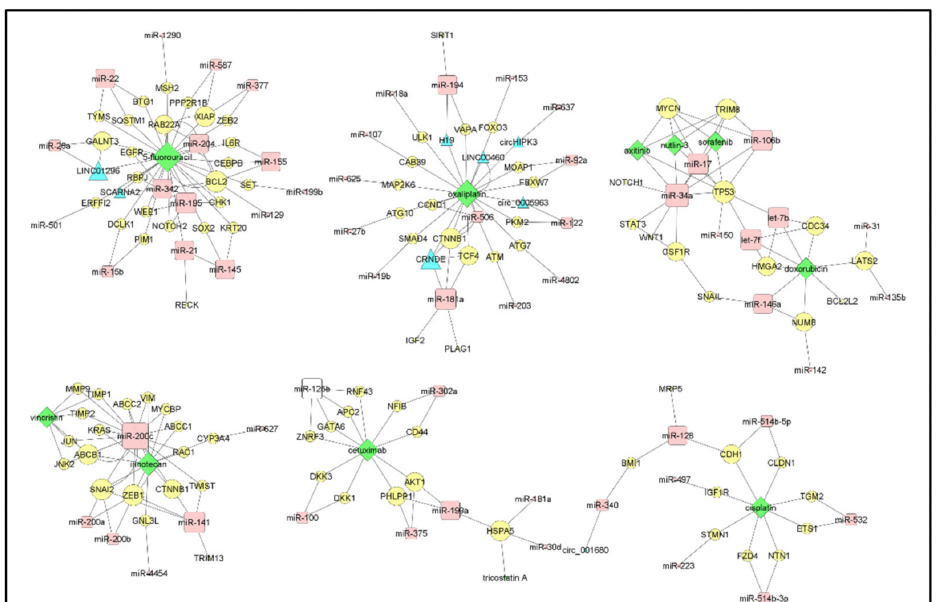
Figure 5. Clusters of miRNAs/targets/upstream regulators connected to the most-studied drugs in the treatment of CRC. Each subnetwork represents a separate cluster of the major drug-centric network (Figure S1). We included miRNAs (red square), their targets (yellow circle) and miRNA and target upstream regulators (sky-blue triangle) connected to the most-studied drug resistances (green rhombus). The map node size was dependent on the nodes’ degree. To build the network, we arbitrarily linked the protein targets or the ncRNA regulator with the drug and the miRNAs to either their targets or ncRNA regulator. The edges here are undirected and, thus, represent associations. Drug abbreviations: 5-FU, 5-fluorouracil; L-OHP, oxaliplatin; CPT11, irinotecan; CET, cetuximab, CDDP: